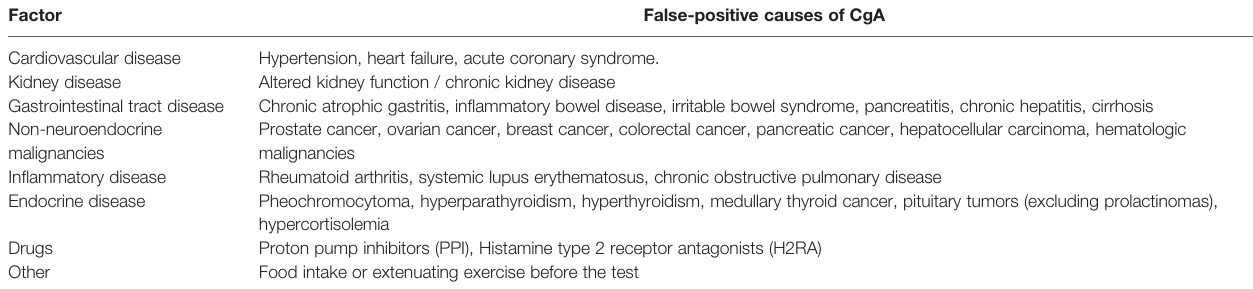
TABLE 5 | Factors that modify CgA concentration.